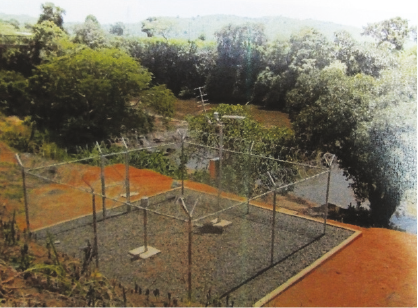
Figure 3: Equipment of the station of Kadey with Batouri in automatic station.